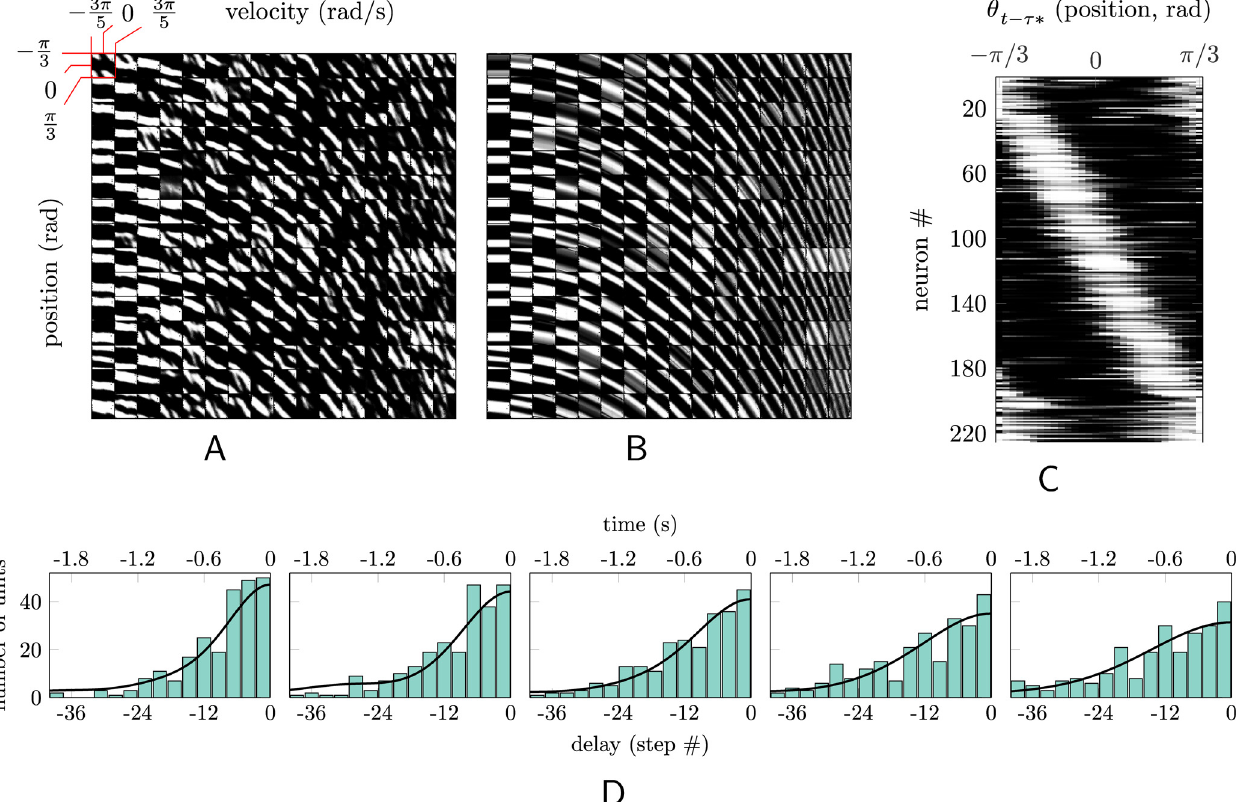
Fig 5. Position and velocity receptive fields of hidden units. In (A)-(C), pure white corresponds to a firing probability of one; pure black to zero. (A) Receptive fields for all 225 hidden units of the spring-free model (see text) in the space of (angular) position (ordinates) and velocity (abscissae). The angle limits and angular-velocity limits, indicated on the first (upper-left) receptive field, are the same for all units. (B) The predicted position-velocity receptive fields of units that have only the lagged-position tuning given by (C). The match with (A) is excellent for all but the anomalous 25 units at the right. (C) The same 225 units, each now plotted as a function of the time-lagged position with which that unit has maximal mutual information. Units have been arranged in order of increasing preferred position, whereas the units in (A) and (B) are arranged in order of maximally informative lags: from top to bottom and left to right, units are tuned for more temporally distant positions. This tuning gives rise to “ stripes ” in position-velocity space. For (A)-(C), the 25 units that do not appear to be well modeled by tuning to past positions have been placed at the end. (D) Histograms of the “ preferred ” lags, in terms both of time and (equivalently) discrete time steps, for five different networks. The normalized autocorrelation of the underlying dynamical system is superimposed. The central panel corresponds to the network analyzed in (A)-(C). The other four panels correspond to networks trained on observations from dynamical systems with different autocorrelations. From left to right panel, the dynamical systems get